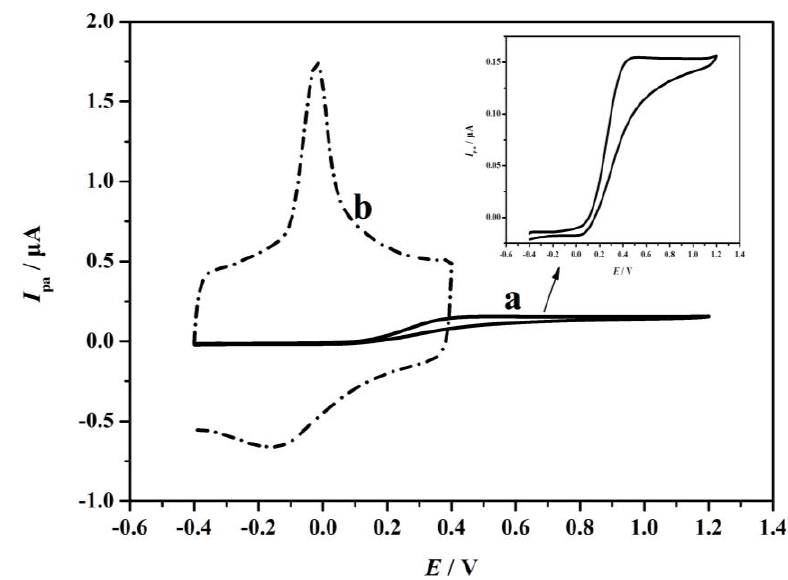
Figure 7. Cyclic voltammograms of 1.0 × 10 −2 mol L −1 AA (pH 6.0) on DMF/carboxyl/MWCNTs/ME (curve a) and PME (curve b) with scan rate of 0.10 V/s.